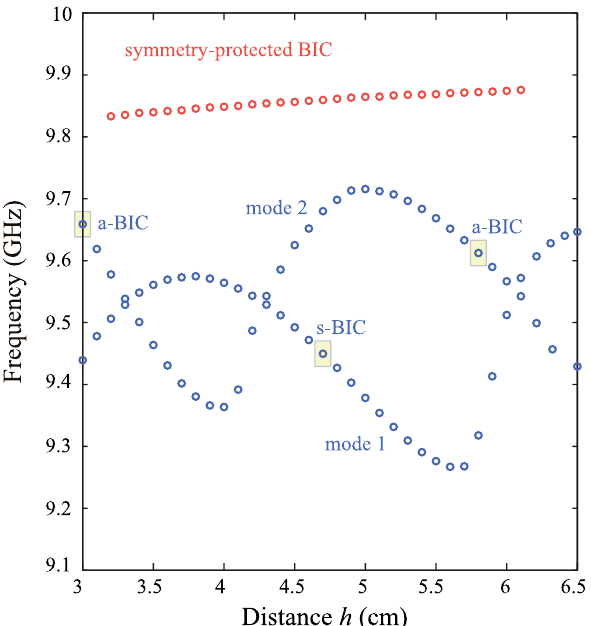
Figure 6: Frequency of three lowest modes of the structure under consideration. The symmetry-protected BIC is denoted as sp-BIC, symmetric accidental BIC – as s-BIC, asymmetric accidental BIC – as a-BIC. The yellow rectangles correspond to accidental BICs [see Figure 1(b)].